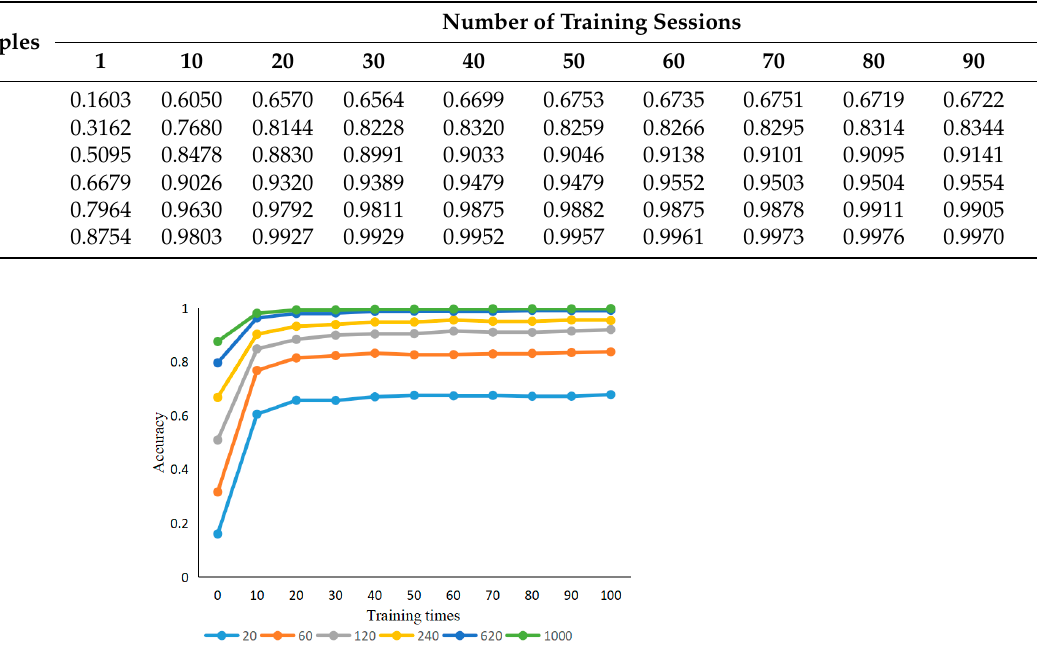
Table 6. Experimental results of fine tuning’s transfer-learning approach.